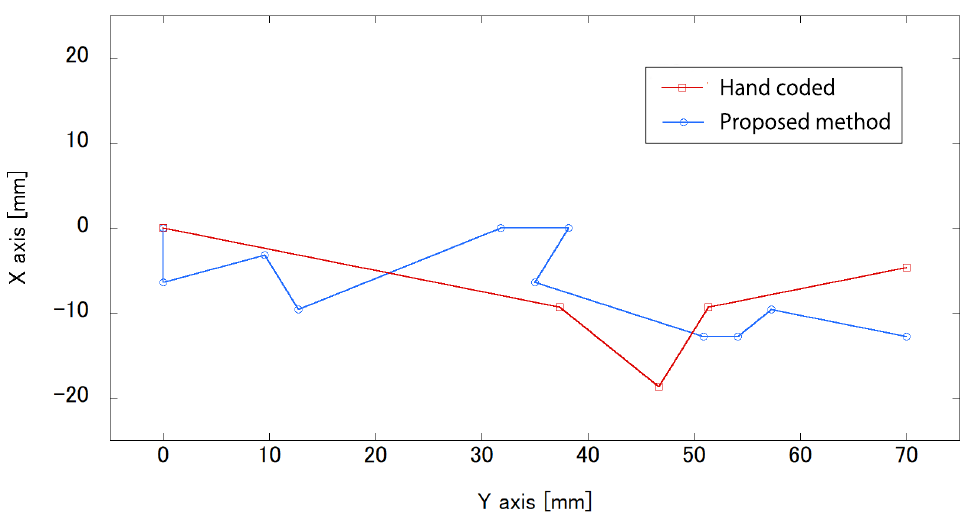
Figure 10. Movement trajectory of Robot 1 when the action-value function is transferred from the virtual agent through body calibration. As a comparison, the movement trajectory of Robot 1 during the transfer of learning using hand-coded inter-task mapping is used.